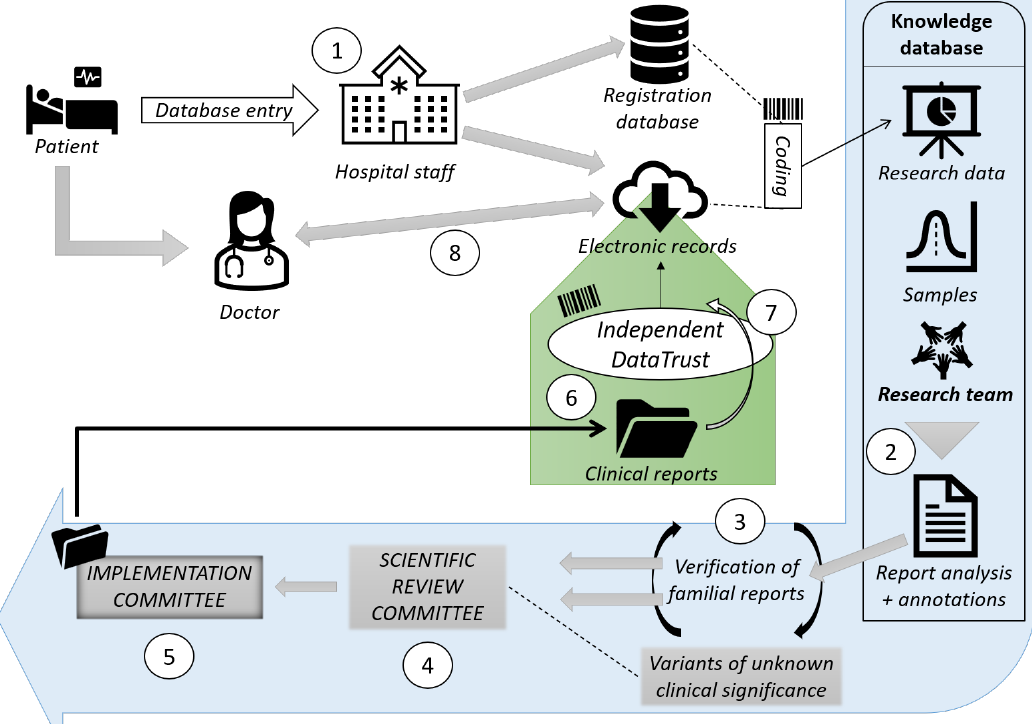
Figure 1. Schematic diagram of dataflow integration.